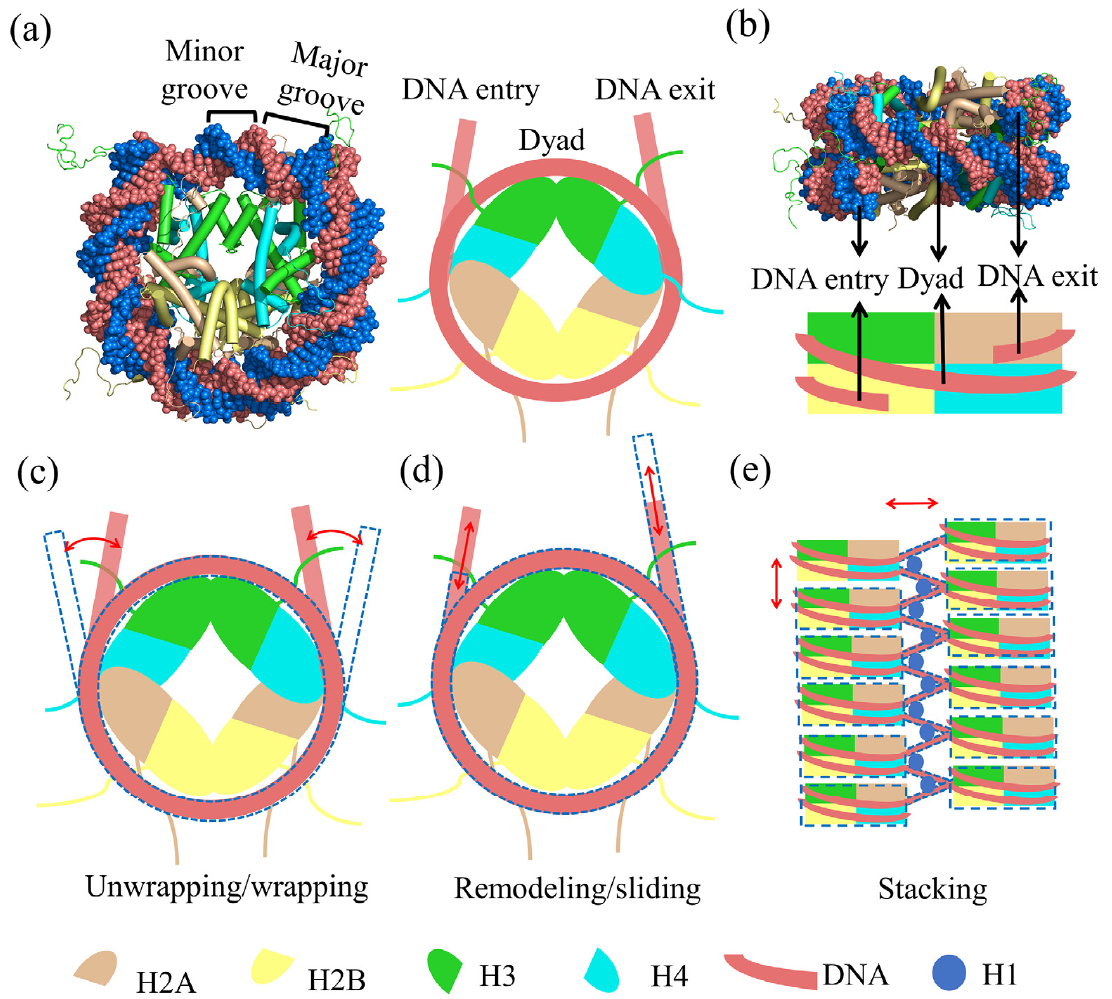
Figure 1. The schematic diagram for the structural basis and dynamic features of nucleosomes. ( a ) The disc-view schematic diagram of the nucleosome structures (PDB number: 1KX5) with histone H2A (brown), H2B (yellow), H3 (green), H4 (cyan), and the nucleosomal DNA (pink and light blue). The schematic diagram is shown next to the crystal structure to depict the topological relationship of the di ff erent components shown in the colored blocks. ( b ) The dyad-view schematic diagrams of the nucleosome structures. ( c ) The wrapping/unwrapping mode for the nucleosomal DNA. ( d ) The remodeling/sliding mode for the nucleosomal DNA. ( e ) The stacking mode for packing the nucleo- some core particle, linker DNA, and linker histone (H1) into a dense state of nucleosomes.